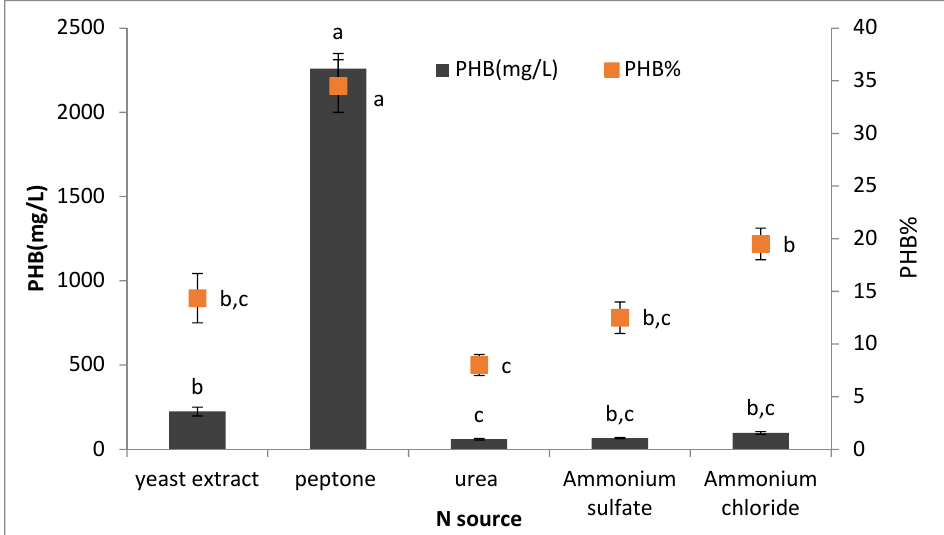
Figure 9. Effects of different N sources on the production of polyhydroxybutyrate (PHB) by Bacillus wiedmannii strain. The ANOVA test was carried out by using SPSS 21 comparisons among means ± SE standard error ( n = 3); different letters show significance at p = 0.05 level based on Duncan’s multiple range test.